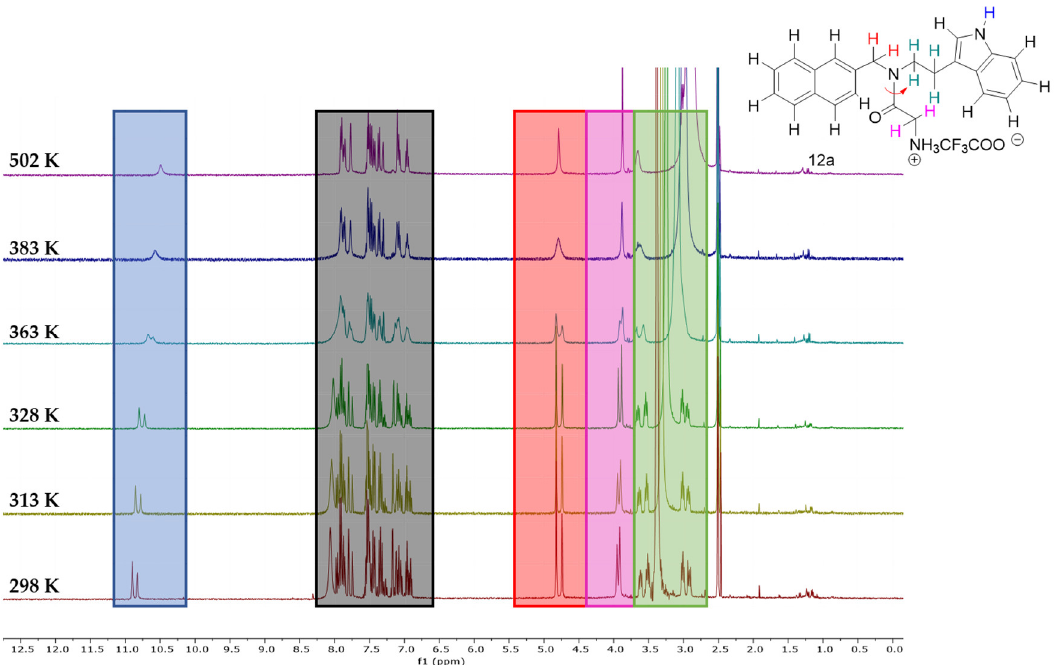
Figure 4. The 1 H NMR spectra of compound 12a at variable temperatures (298–502 K) in DMSO-d 6 .